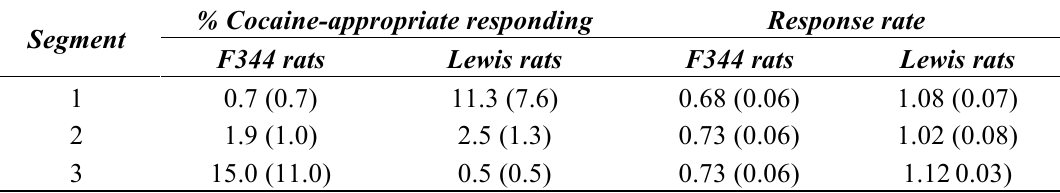
Table 1. Baseline Vehicle Test in Cocaine Test Groups . Mean (± S.E.M.) percent cocaine-appropriate responding and response rates (total lever presses/sec) during a cumulative dosing session with vehicle injections in F344 and Lewis rats in the cocaine test groups.